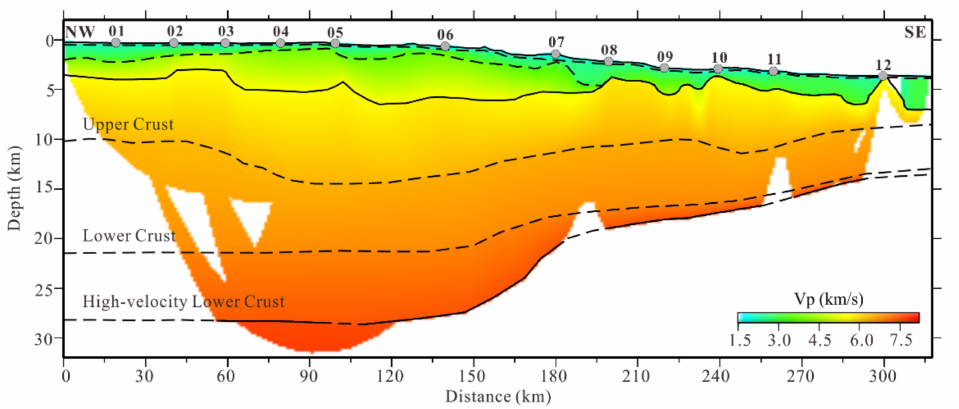
Figure 3. The forward P-wave velocity model along profile NS5. Gray circles represent OBS